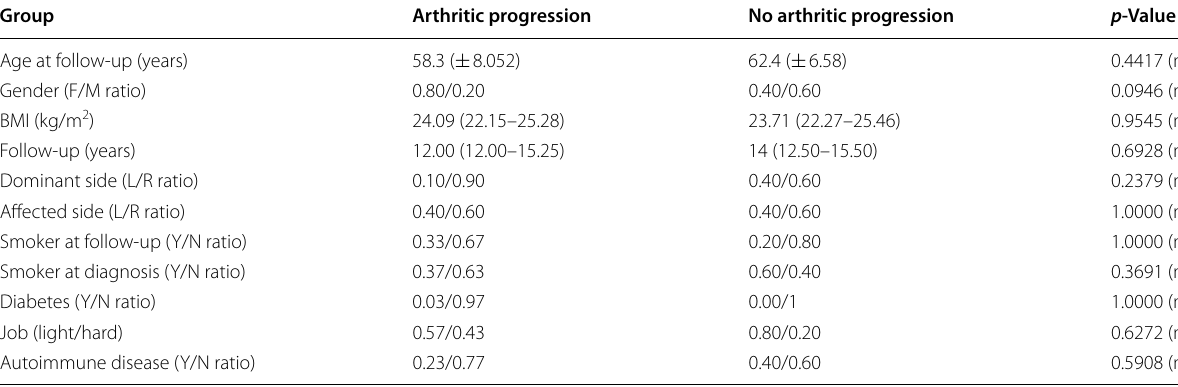
Data are reported as mean (